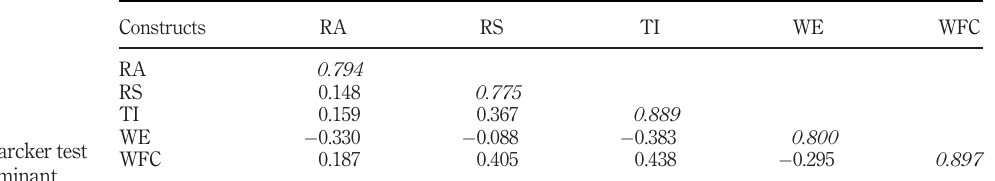
Table 3. Measurement model outcome